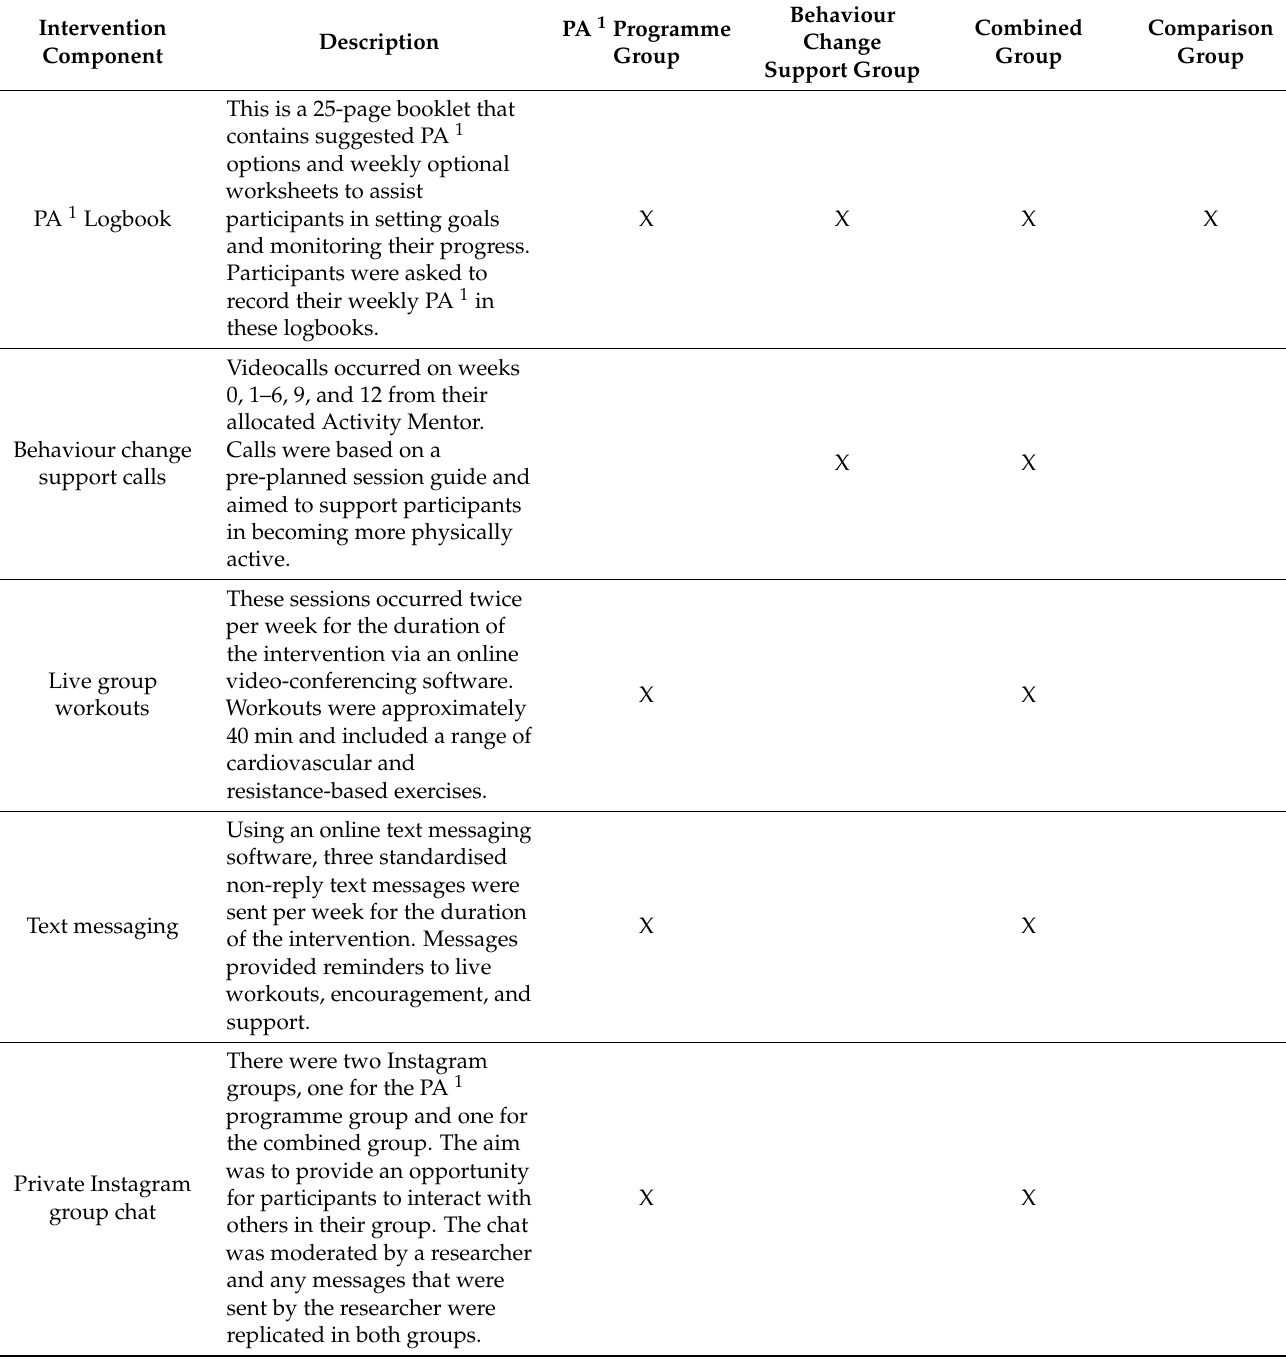
Table 1. Details of intervention components and corresponding intervention